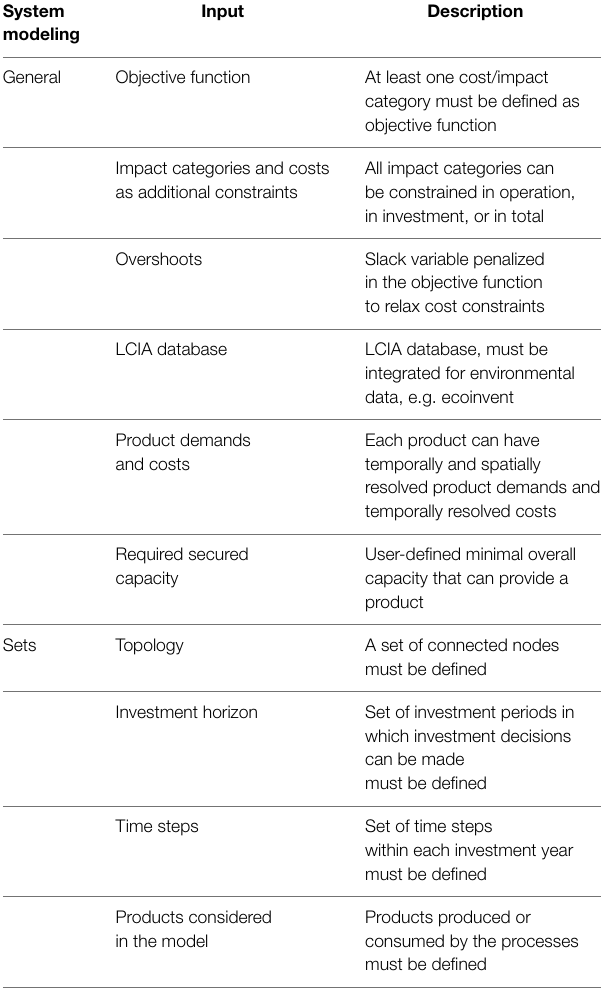
TABLE 1 | Input data for system modeling in